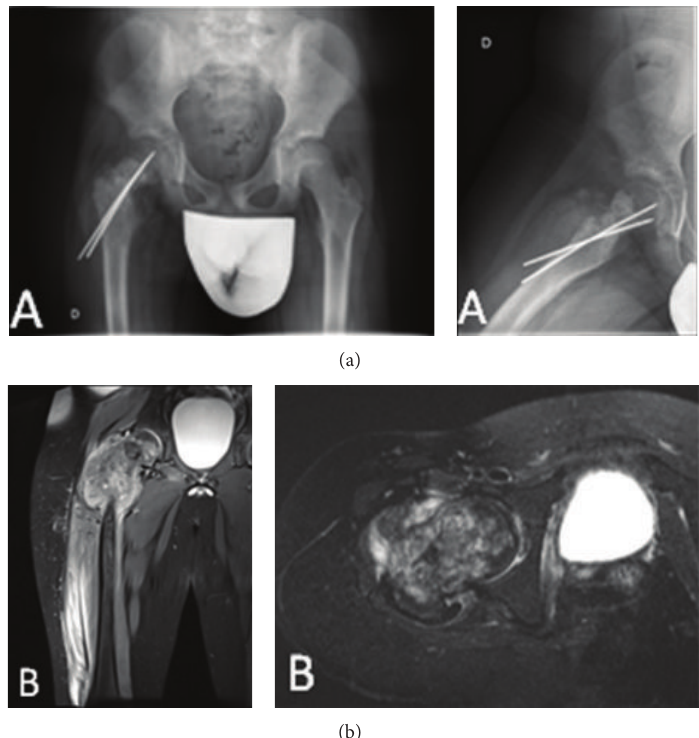
Figure 1: (a) Plain radiographs of the pelvis, hip, and proximal femur showing mixed osteolytic and sclerotic areas in the right proximal femur and an unhealed femoral neck fracture fixed with two K wires. (b) MRI showing a proximal femoral lesion extending distally 13 cm with a surrounding soft-tissue